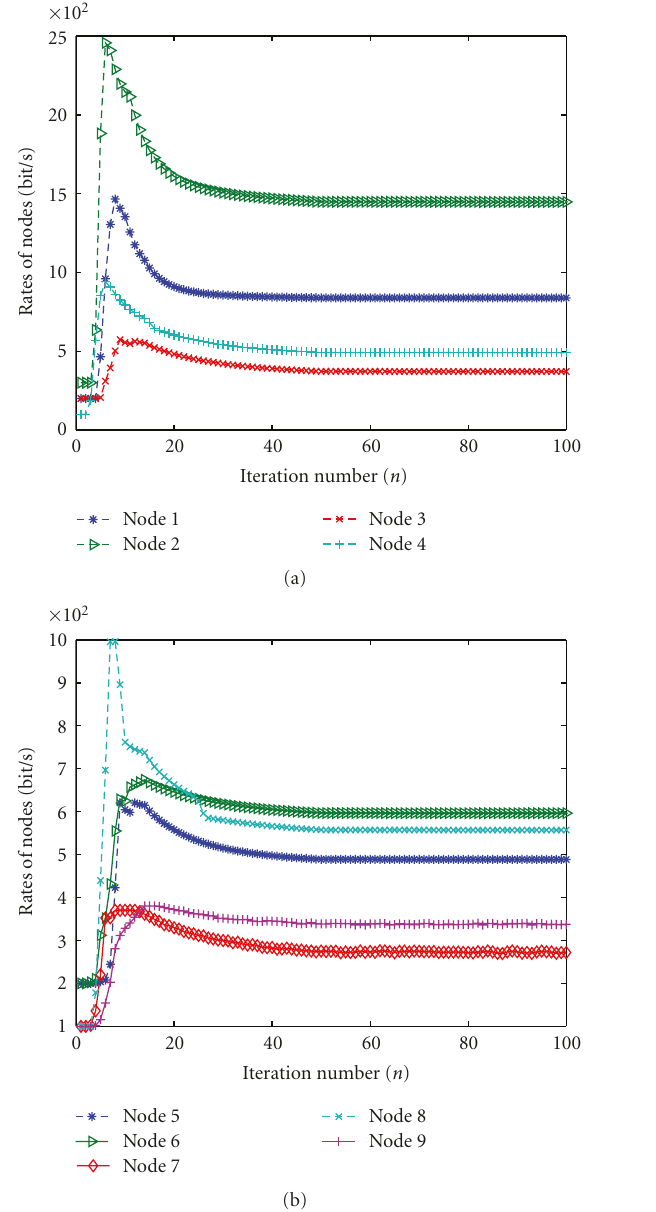
Figure 4: Convergence of the ASMOP algorithm by using linear weighted